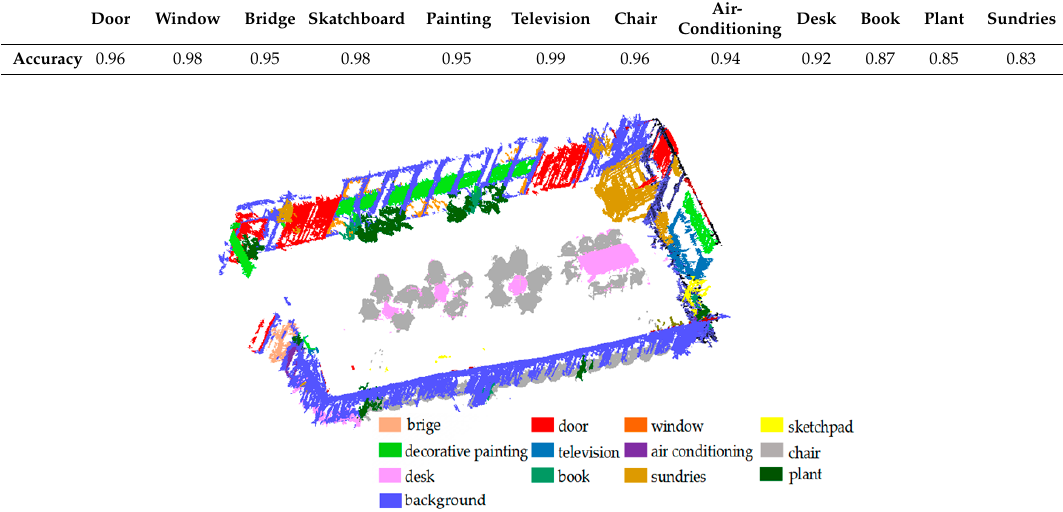
Figure 9. The fine-level labeling results of the point model for the meeting room.